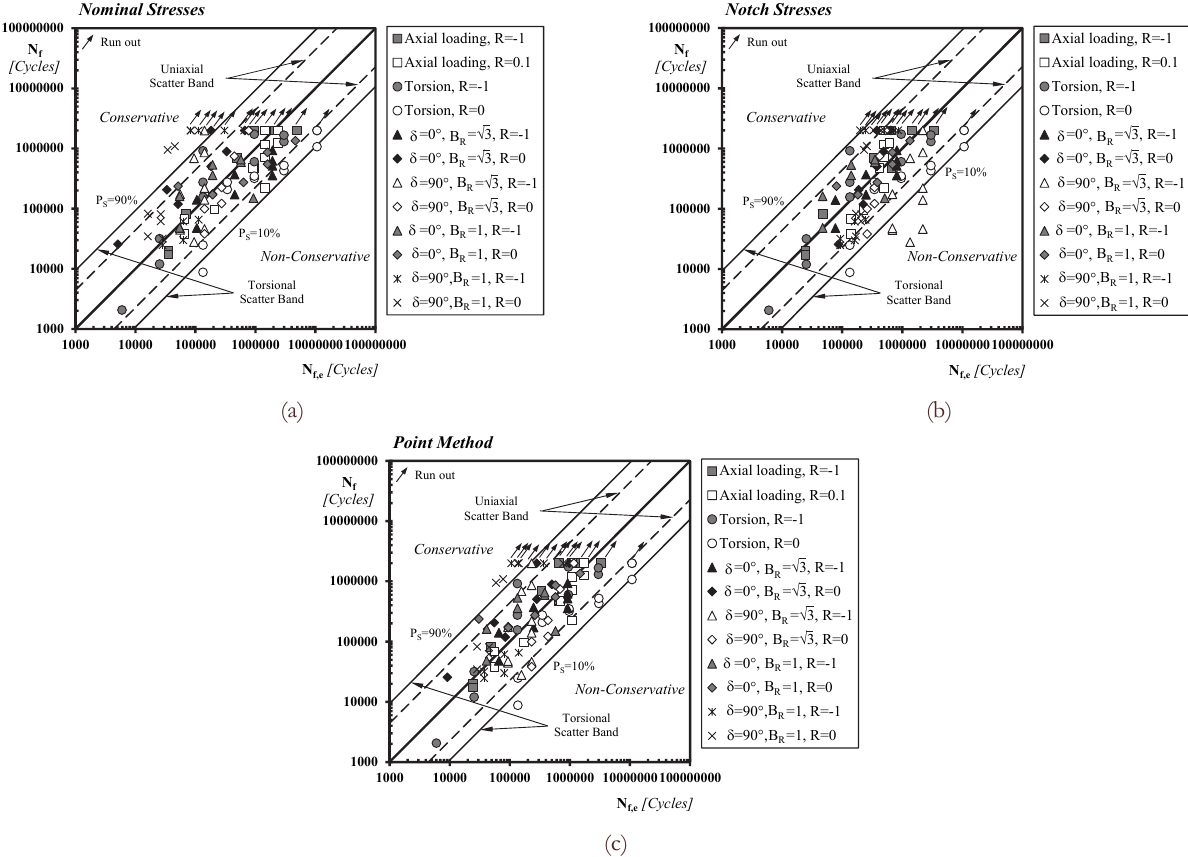
Figure 4: Accuracy of the MWCM applied in terms of nominal (a) and notch stresses (b) as well as along with the Point Method